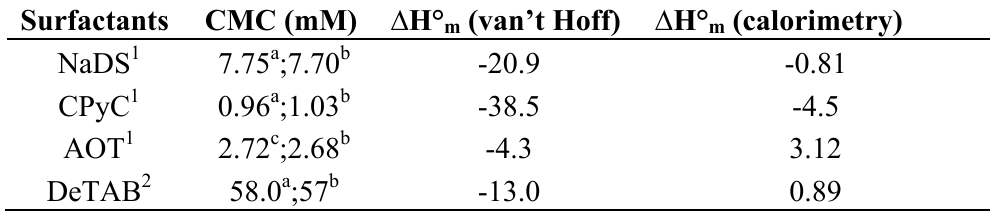
Table 1. The CMC and the enthalpies of micellization of some surfactants in water at 298